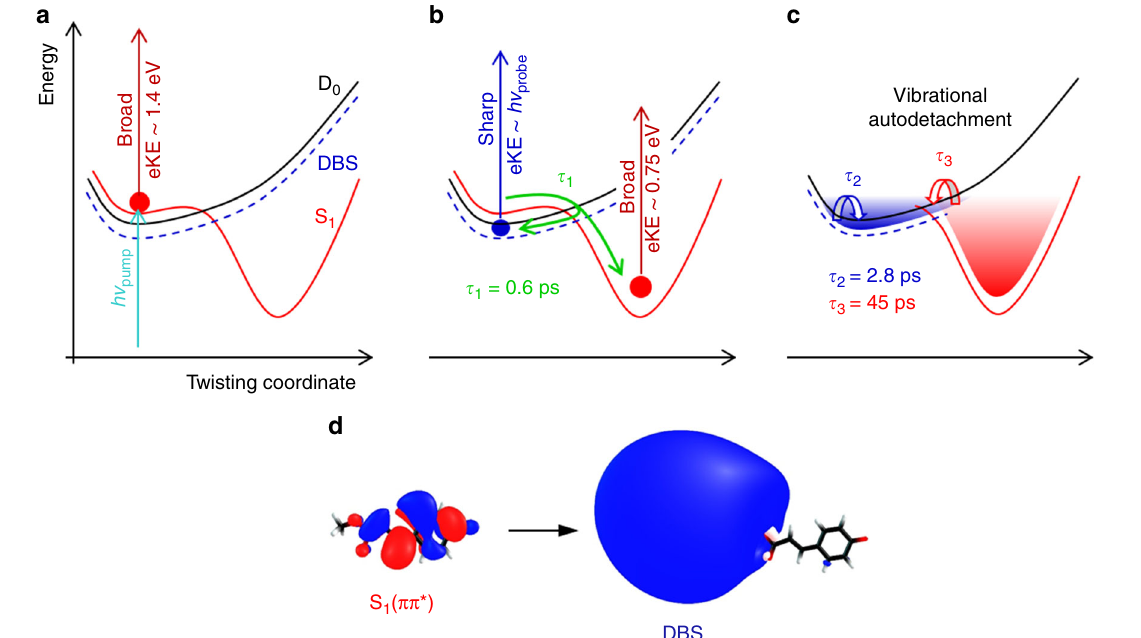
Fig. 3 Interpretation of the time-resolved dynamics for p CEs − . a At Δ t ≈ 0, S 1 ( ππ *) population leads to a broad, high-eKE distribution. b Rapid nuclear motion away from the Franck-Condon geometry to a twisted intermediate ( τ 1 = 0.6 ± 0.1 ps) gives rise to the broad signal peaking around eKE ≈ 0.75 eV. Concurrently, there is internal conversion to a DBS, leading to the sharp eKE signal at eKE ≈ h ν probe . c DBS and twisted intermediate populations decay through vibrational autodetachment with lifetimes τ 2 = 2.8 ± 0.7 and τ 3 = 45 ± 4 ps, respectively. d CCSD natural orbitals for the S 1 ( ππ *) state and DBS at the initial anion geometry (80% isodensity